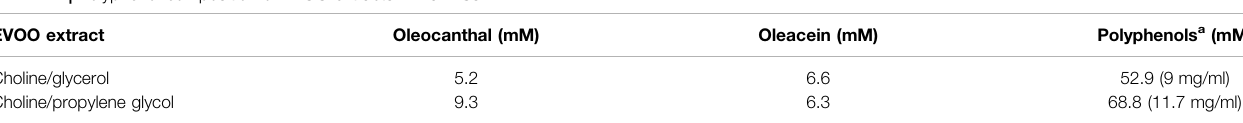
TABLE 2 | Polyphenol composition of EVOO extracts in NaDESs.